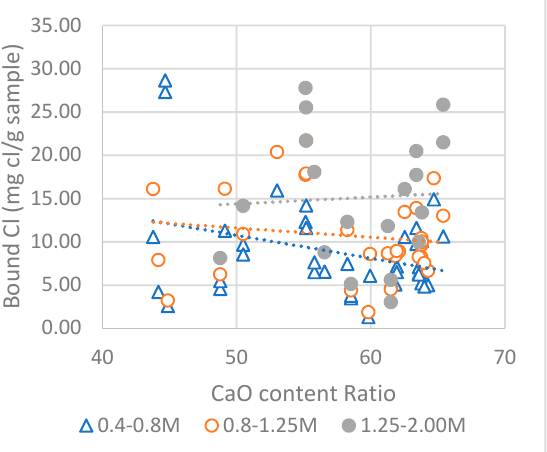
Figure 9. Relation between CaO ratio and bound chloride for different chloride concentrations for all data.